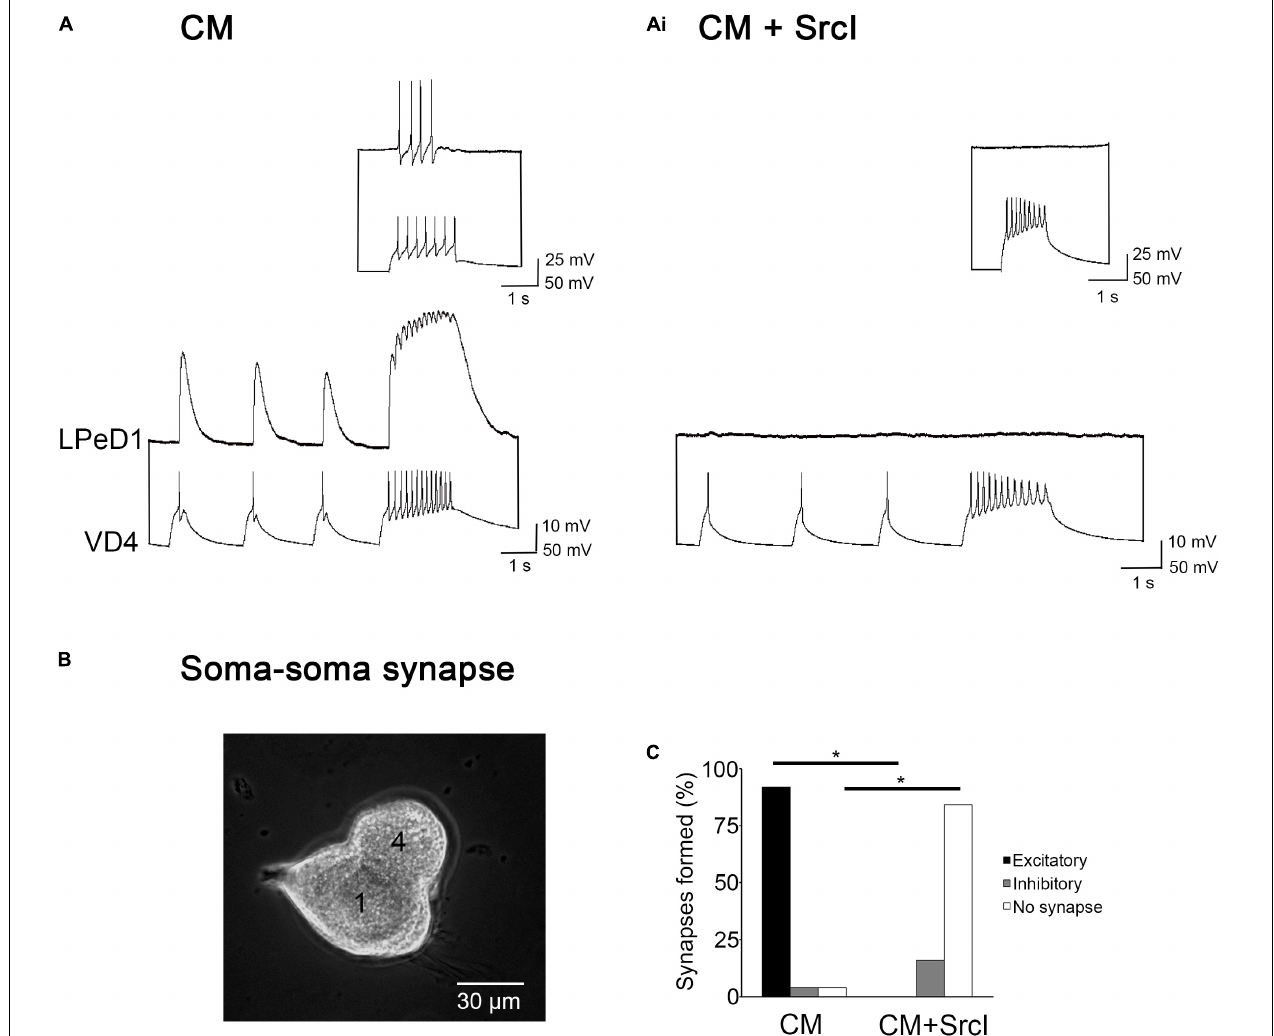
FIGURE 1 | Src family kinases (SFKs) are required for soma–soma synapse formation between visceral dorsal 4 (VD4) and left pedal dorsal 1 (LPeD1) neurons. (A) Individual VD4 and LPeD1 neurons were paired in a soma–soma configuration overnight in conditioned media (CM). Both cells were impaled with sharp intracellular electrodes the next day and held at –100 mV for consistency. Action potentials triggered in VD4 induced 1-for-1 excitatory postsynaptic potentials (EPSPs) in LPeD1 ( n = 25). Inset: a train of action potentials triggered in VD4 induced spiking in LPeD1 when held at –60 mV, confirming the presence of an excitatory synapse. (Ai) The SFK inhibitor, SrcI (5 µ M), prevented synapse formation ( n = 19). Action potentials triggered in VD4 did not induce a response in LPeD1 at –100 mV, or near threshold (–60 mV; inset). (B) Experimental preparation. Phase contrast image of a soma–soma synapse imaged at 20 × magnification. 4 =